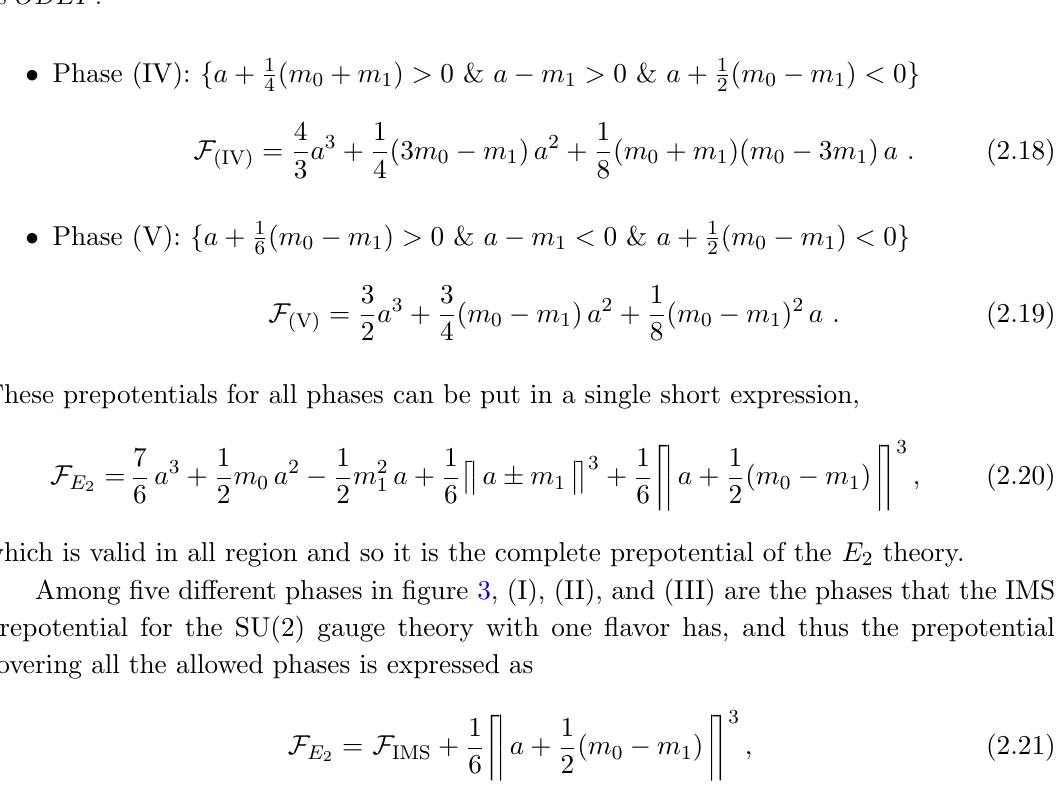
Figure 4 . The parameter space of the E 2 theory, which is identi(cid:12)ed as the K(cid:127)ahler cone of the corresponding geometry. The allowed parameter region is the space which is surrounded by the three planes represented by OAB , OBC , and OCD , respectively. If we (cid:12)x the mass parameters m 0 and m 1 , this allowed region is identi(cid:12)ed as the physical Coulomb moduli. This allowed parameter region is divided into (cid:12)ve phases due to the three internal \walls", which are represented by OAE , OCD , and ODE , respectively. These walls are the place where the (cid:13)op transition occurs. Especially, Phase (I) is identi(cid:12)ed as the region surrounded by these three internal walls, which we represent as ODEF